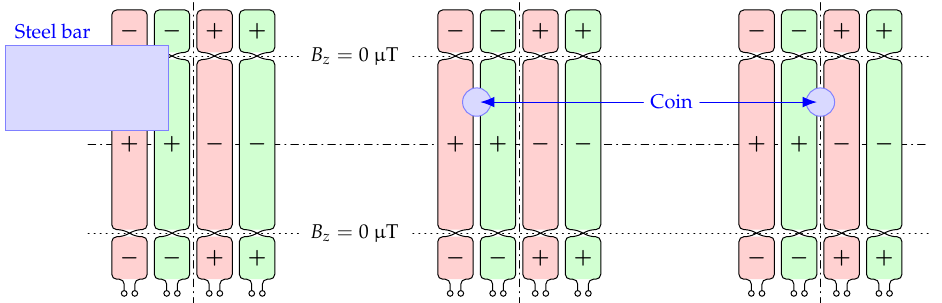
Figure 19. Foreign objects at the outer edge of a conductor loop of the green sensor coil—the signs symbolize the orientation of the conductor loops, the colors the different coil pairs ( left ) Steel bar ( middle ) Coin between two identically oriented conductor loops ( right ) Coin between two oppositely oriented conductor